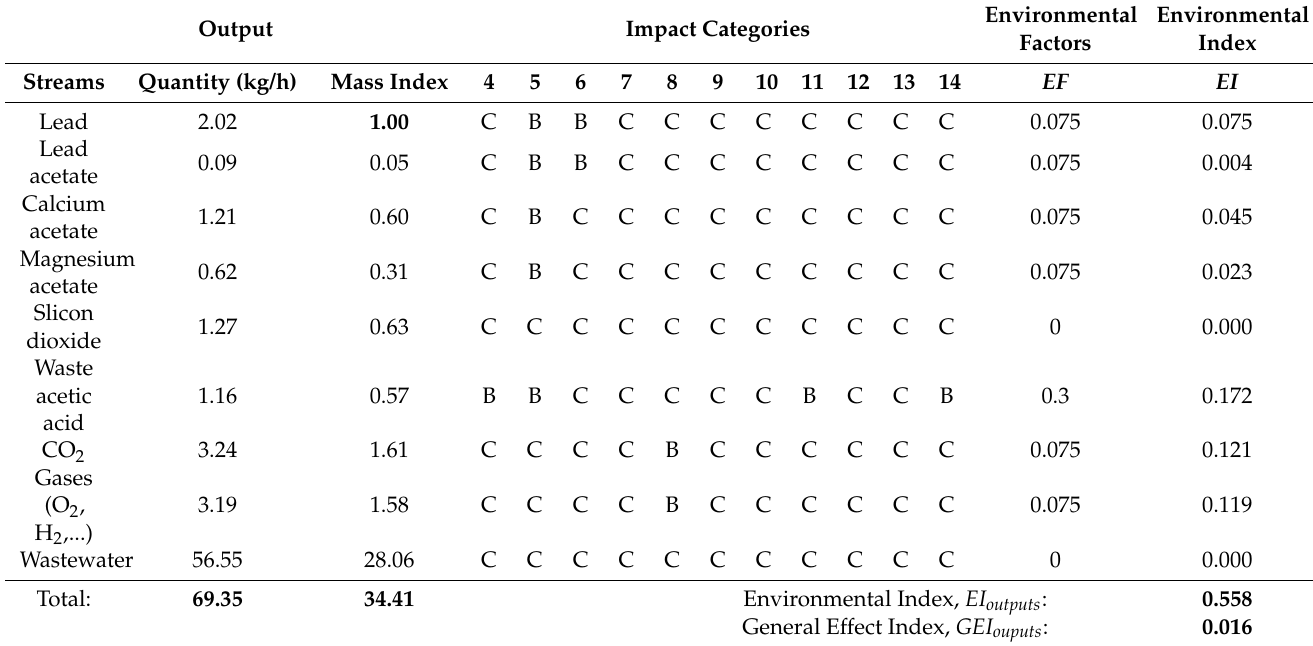
Table 4. Output impact